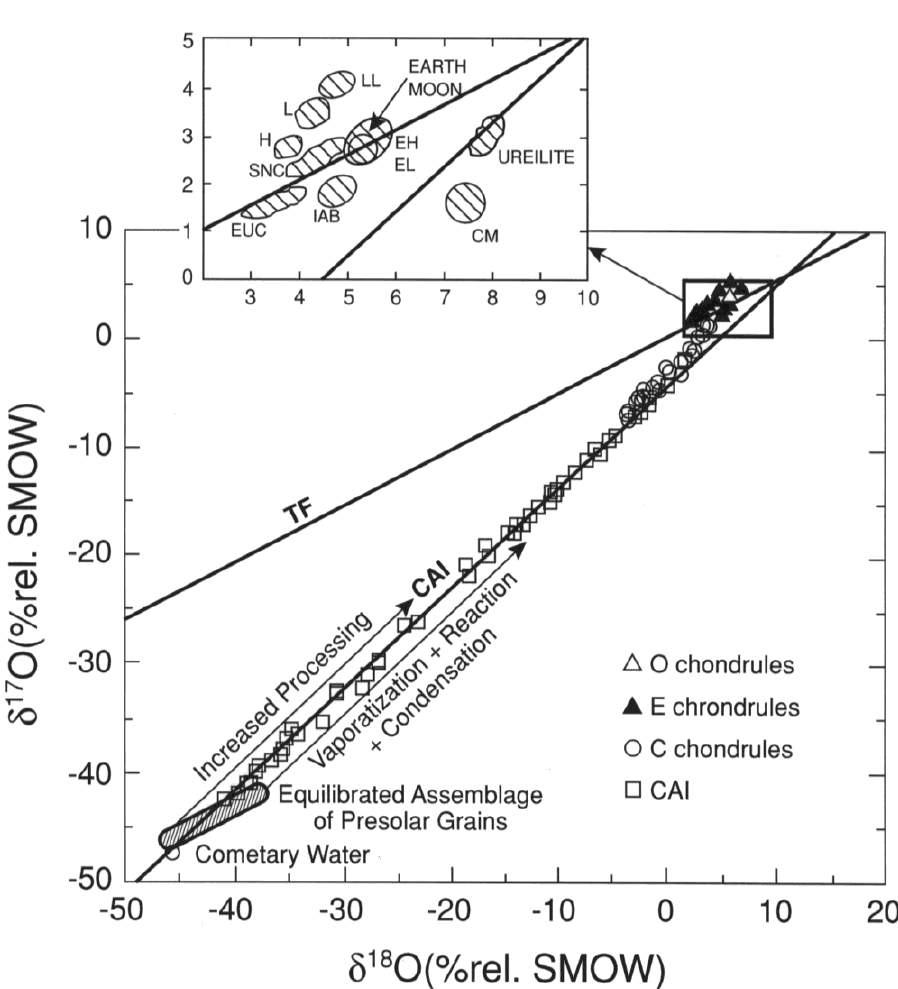
Figure 1. A typical three-isotope plot of oxygen isotopes in calcium-aluminum-rich inclusions (CAIs) and chondrules, and in various meteorite types (note that the label “O chondrules” refers to chondrules from ordinary chondrites, “E chondrules” from enstatite chondrites, “C chondrules” from carbonaceous chondrites and TF is the Terrestrial Fractionation line). The CAI line delineates the evolution of oxygen in solids either by the CAI line can react and fractionate along slope 0.52 lines to broaden the CAI